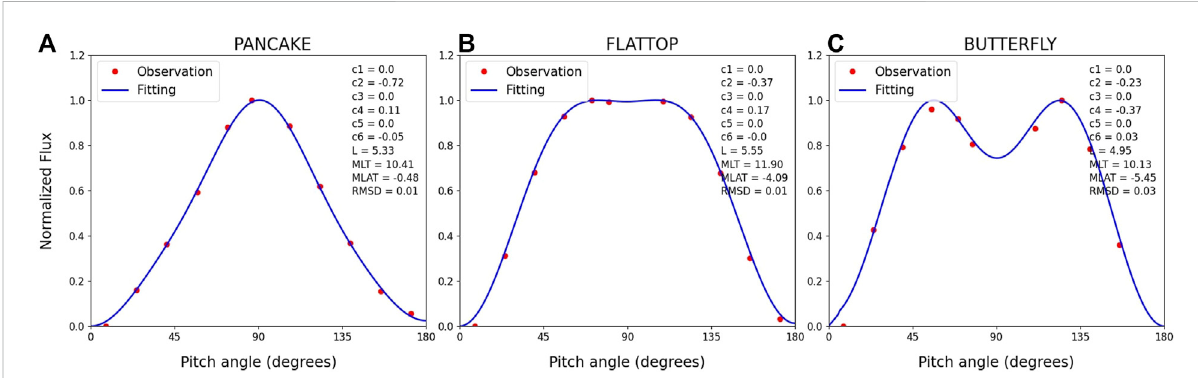
FIGURE 1 Examples of (A) pancake, (B) fl attop and (C) butter fl y pitch angle distributions. The red fi lled circles are normalized electron fl ux of 143 keV electrons measured by MagEIS instrument on-board the Van Allen Probe-A spacecraft (propagated to the magnetic equator and averaged in 5 min assuming symmetric distribution around 90 ° pitch angle), and blue curves show the Legendre polynomial fi tting results. The fi rst six Legendre coef fi cients ( c 1 − c 6 ), RMSD and magnetic ephemeris information (L, MLT, MLAT) are provided in each